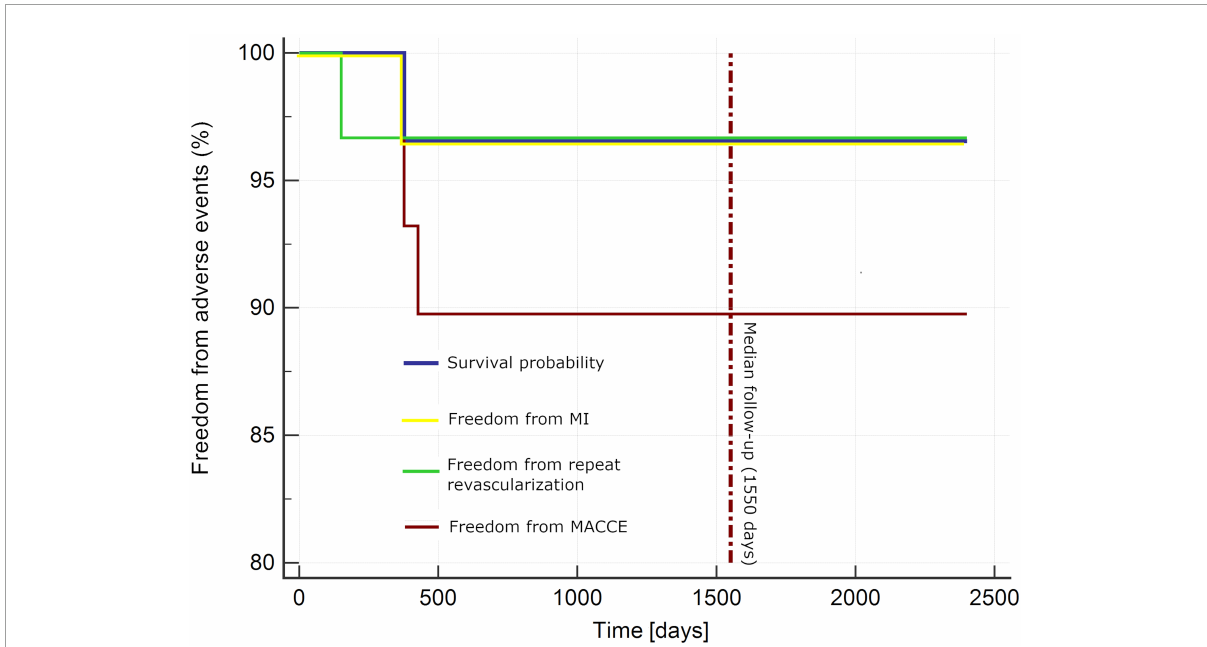
FIGURE1 Kaplan–Meier curve for adverse events. MACCE, major adverse cardiac and cerebrovascular incidents (death, myocardial infarction, stroke, repeat revascularization); MI, myocardial infarction.